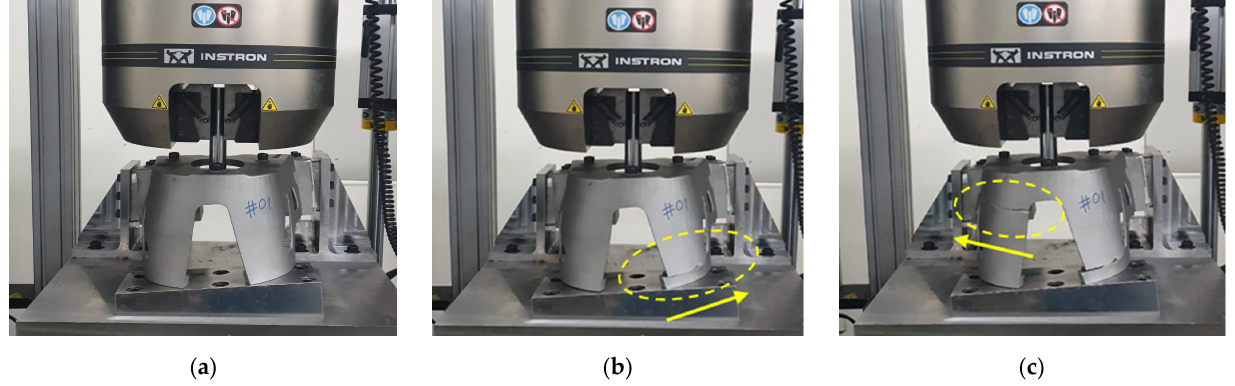
Figure 10. Tensile experiment process: ( a ) the initial stage of tension; ( b ) the stage immediately after the initial fracture; ( c ) the stage of the end of the experiment.